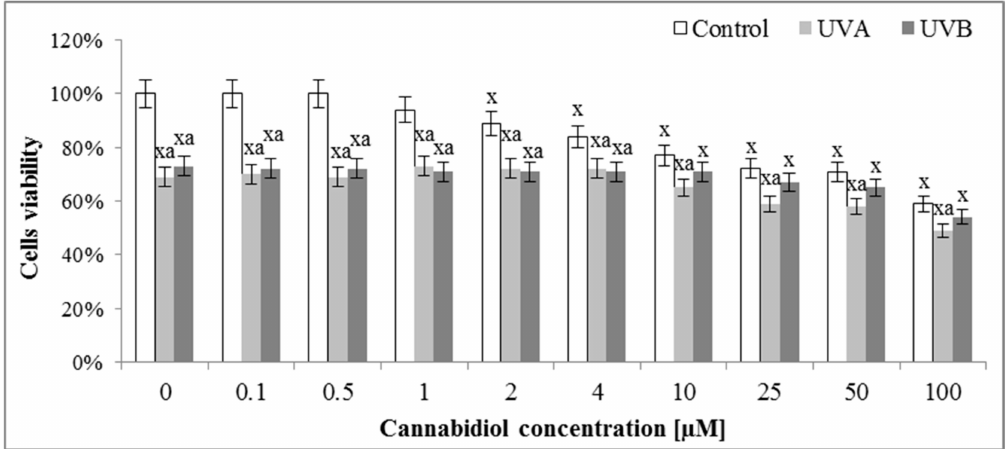
Figure 2. The influence of cannabidiol (CBD) on viability of keratinocytes exposed to UVA (30 J / cm 2 ) and UVB (60 mJ / cm 2 ) irradiation measured by MTT test. Mean values ± SD of five independent experiments are presented: x statistically significant di ff erences vs. group without radiation or chemical treatment, p < 0.05; a statistically significant di ff erences vs. UVA or UVB group, p <